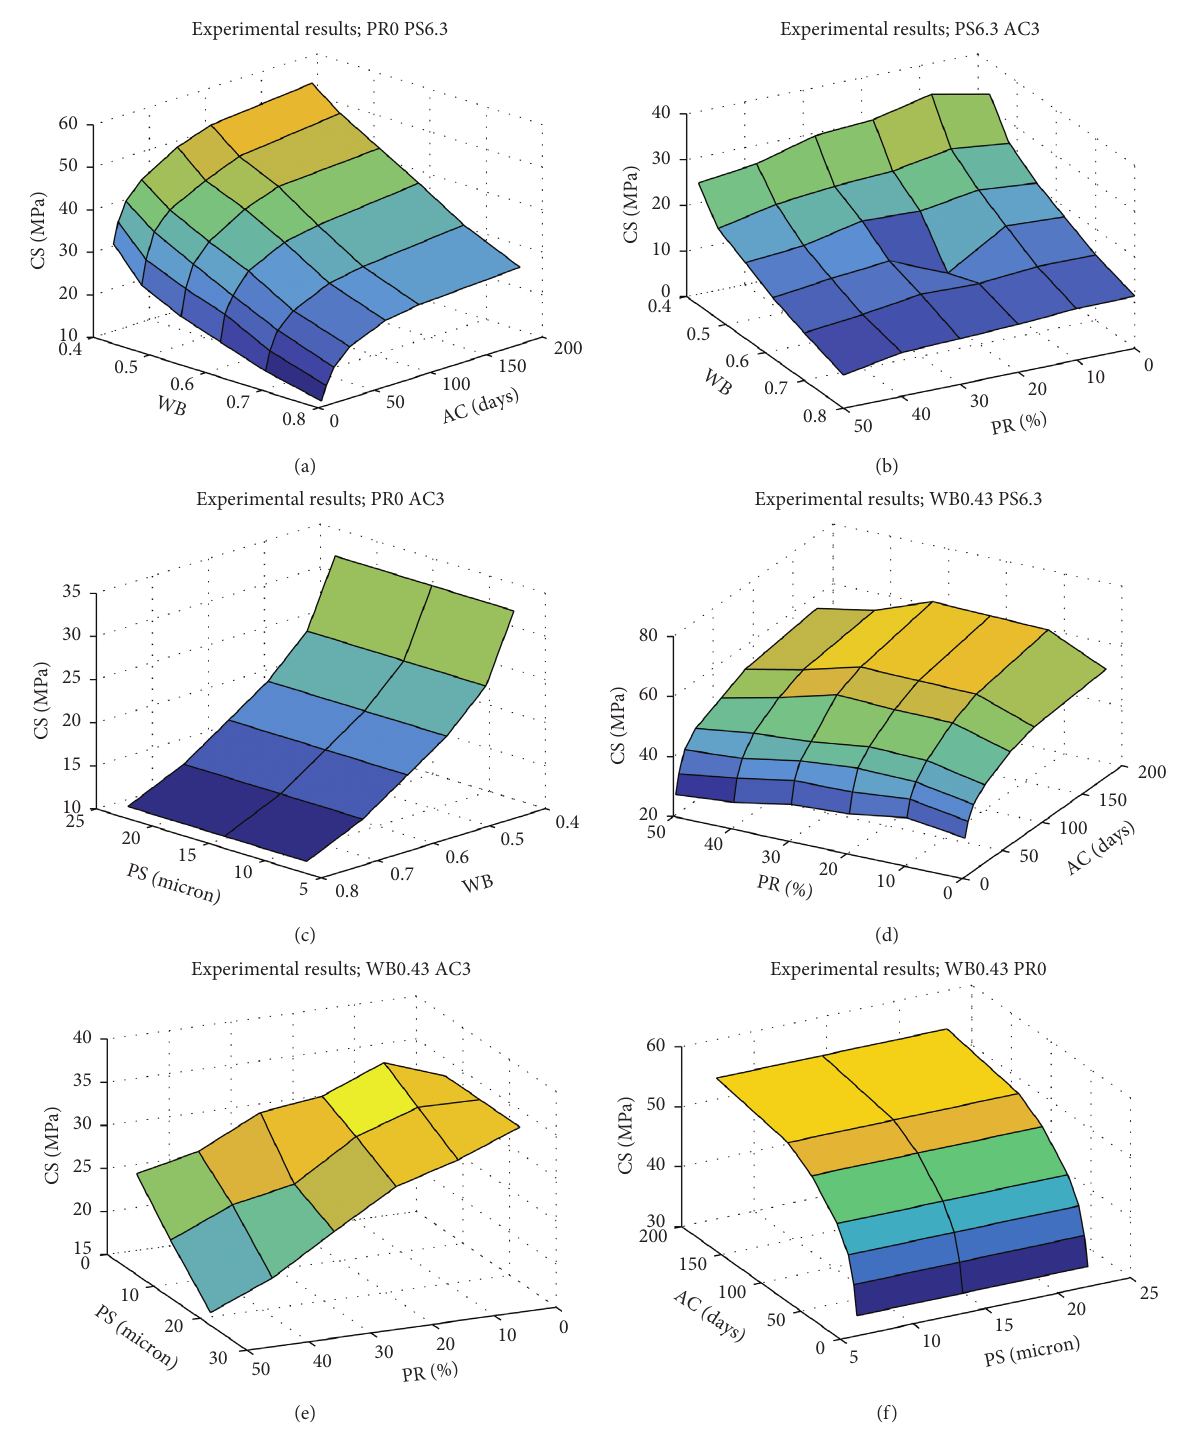
Figure 1: The 3D plots of experimental results with the factor parameters of WB � 0.43, PR � 0, PS � 6.3, and AC � 3. (a) PR � 0 and PS � 6.3. (b) PS � 6.3 and AC � 3. (c) PR � 0 and AC � 3. (d) WB � 0.43 and PS � 6.3. (e) WB � 0.43 and AC � 3. (f) WB � 0.43 and PR � 0.